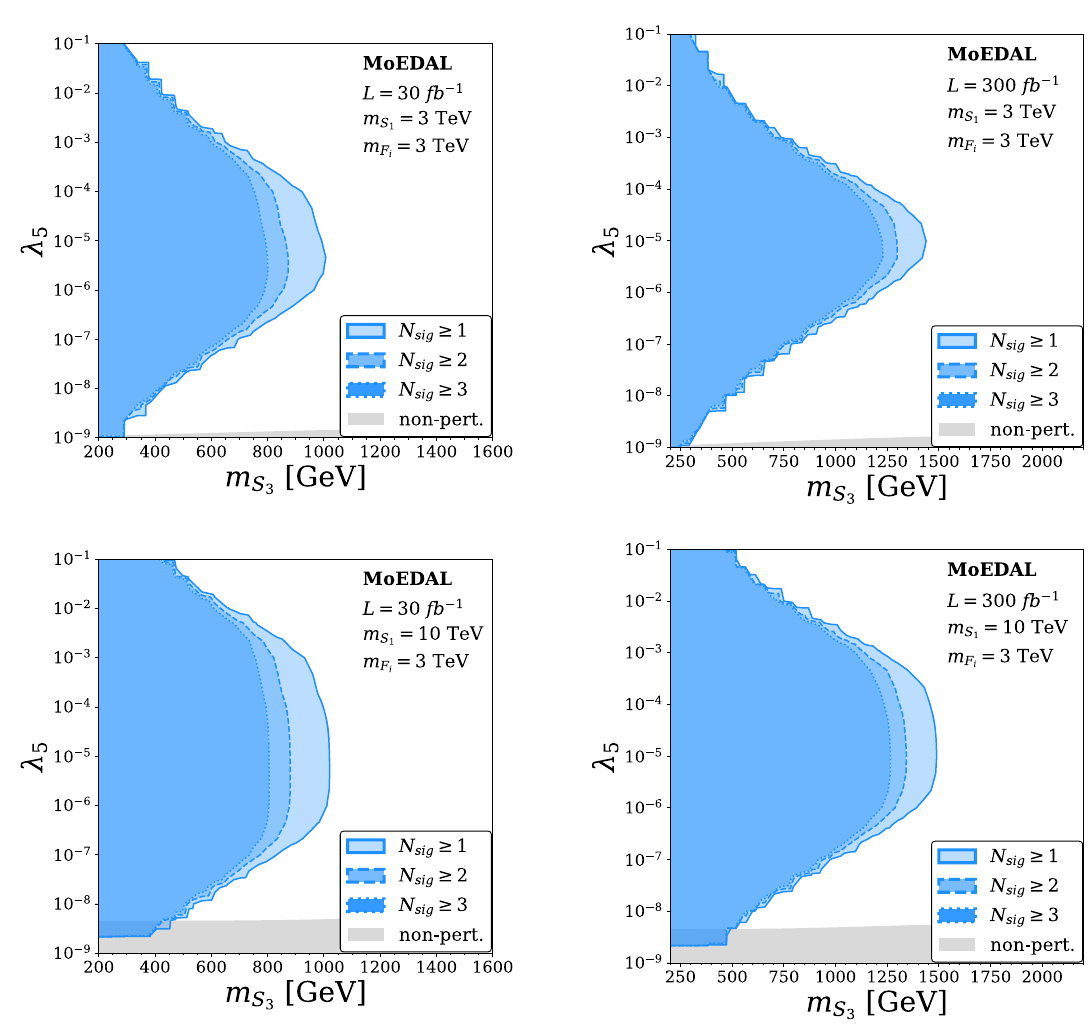
= 3 TeV ( i = 1 , 2 , 3) i F (cid:15) (cid:14) ) | , | ( h ¯ ) | ≥ | ( h F ij ij F